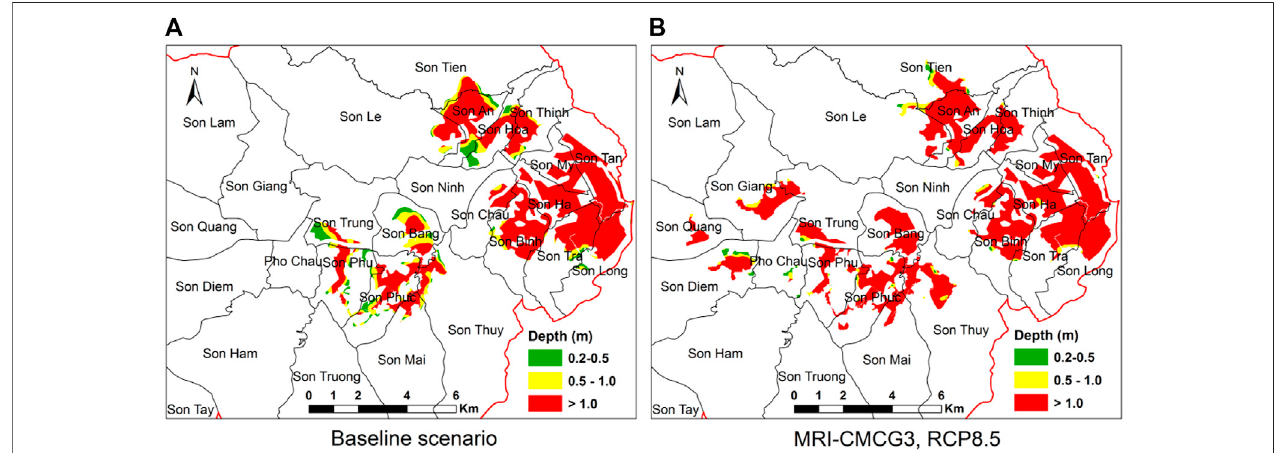
FIGURE 12 | Map of classi fi ed inundation depth upon rice cultivation area.